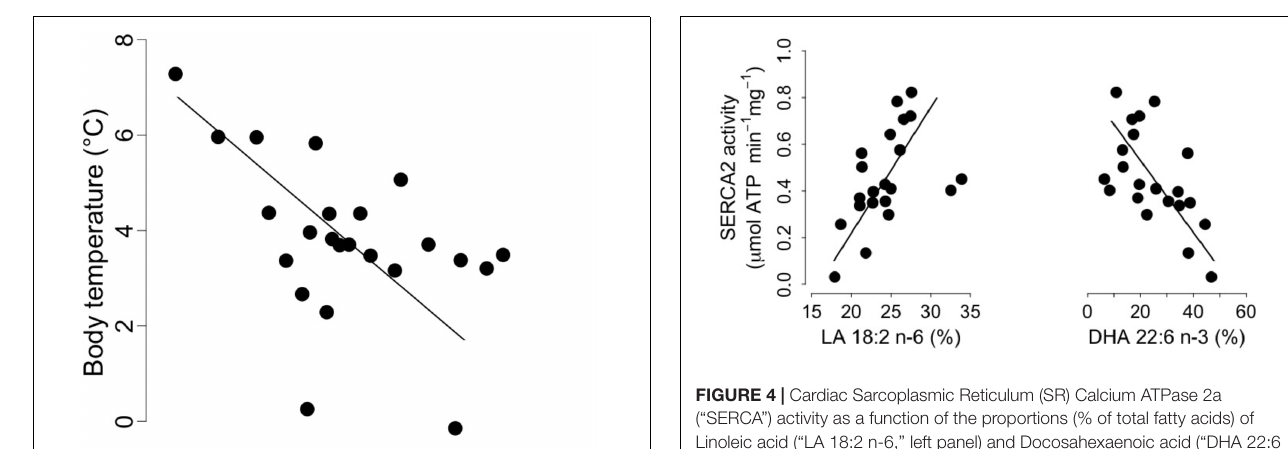
their onset of hibernation, compared to individuals fed a CO